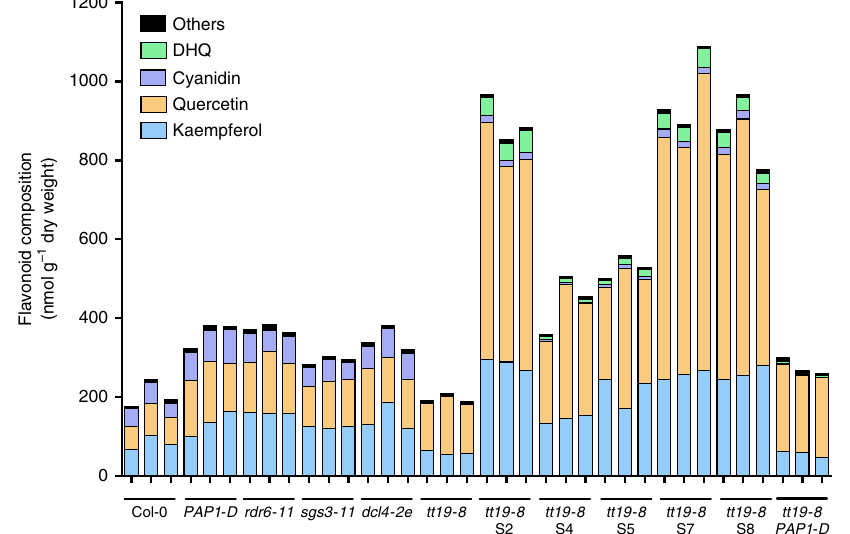
Fig. 3 Flavonoid composition of 4-day-old Arabidopsis seedlings grown in AIC of the genotypes indicated. Compounds were evaluated by LC-MS/MS against a set of authentic standards of known concentration. Blue, kaempferol; orange, quercetin; purple, cyanidin; green, dihydroquercetin (DHQ); and black, others include apigenin, luteolin, naringenin, eriodictyol, dihydrokaempferol, pelargonidin, epicatechin, and peonidin. Source data are provided as a Source Data fi